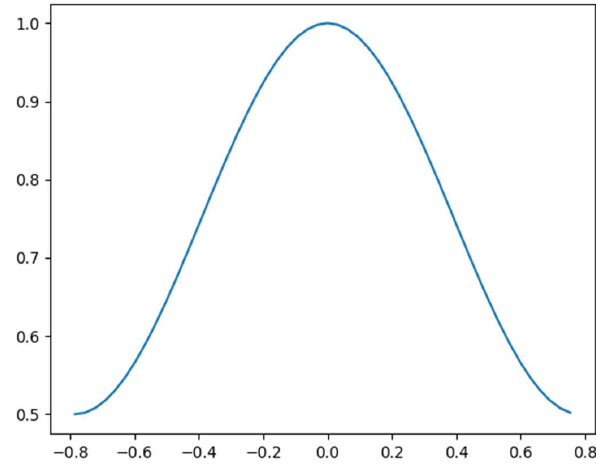
Figure 4. Visualization of rotational uncertainty function.